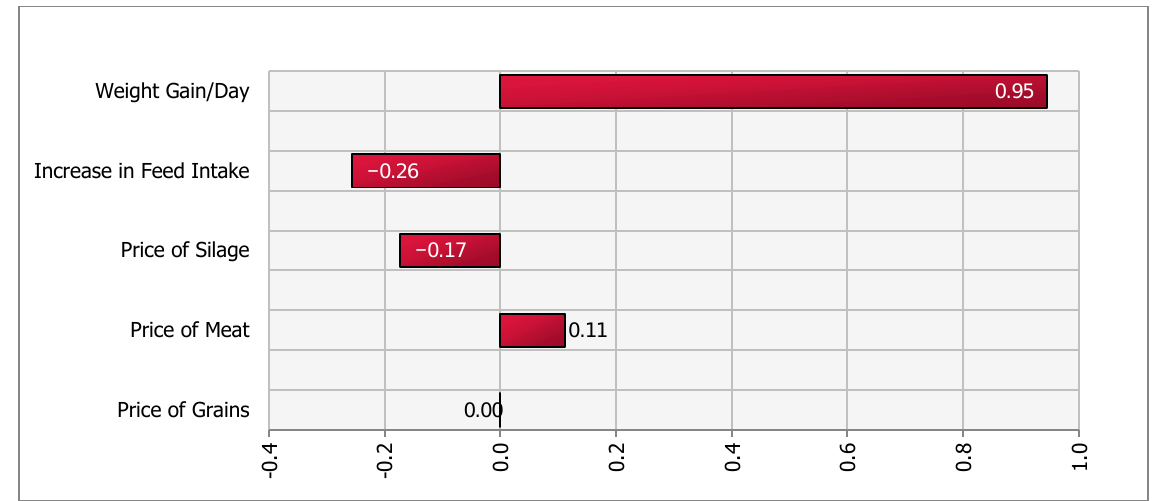
Figure 3. Tornado plot of regression coefficients for determinants of a change in net income under increased space allowance (from 2.2 to 2.7 m 2 /calf)—Scenario 2a.